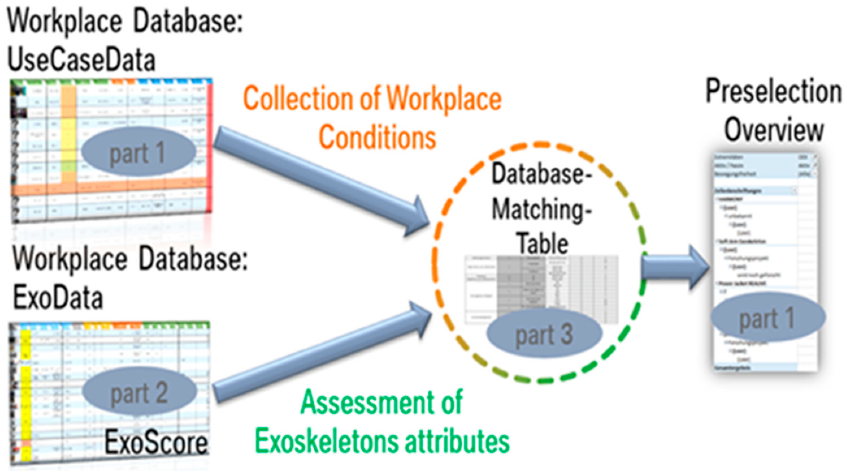
Figure 3. ExoMatch: method for preselecting most suitable exoskeletons depending on workplace © [1].